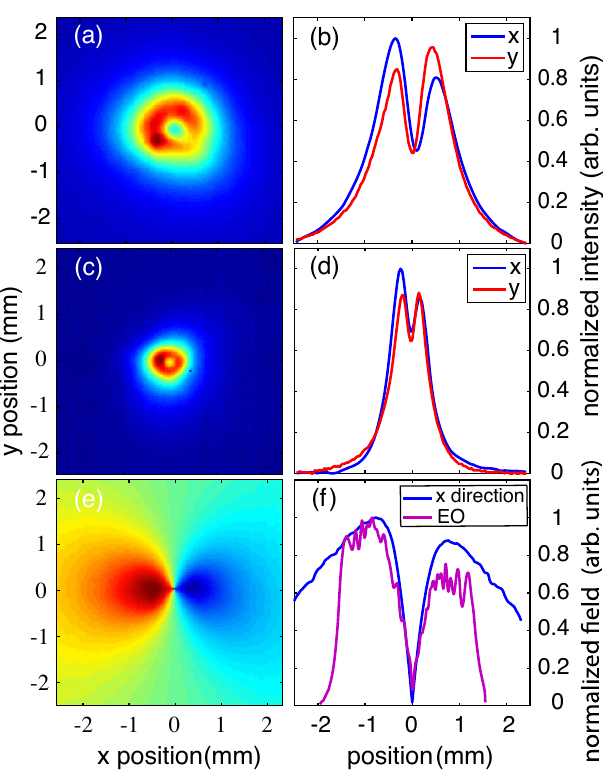
FIG. 7. The spatial distribution of the THz focal spot with (a) OAP2 (D ¼ 50 . 8 mm, f ¼ 101 . 6 mm) and (c) OAP (D ¼ 50 . 8 mm, f ¼ 50 . 8 mm). (b), (d) Cross-section intensity profiles of the THz image in (a) and (c). (e) The field distribution convert from intensity distribution of (a). (f) The projection of the THz field strength (absolute value of amplitude) in the horizontal direction of the spatial